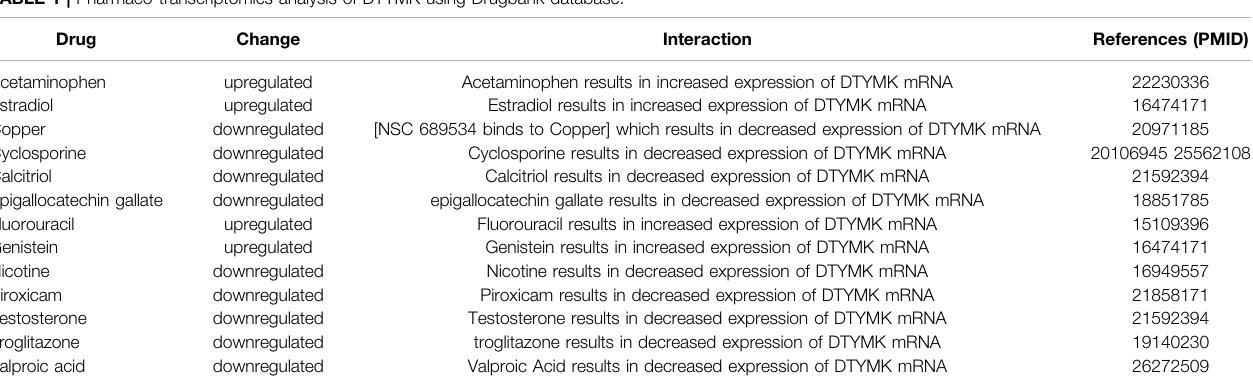
TABLE 1 | Pharmaco-transcriptomics analysis of DTYMK using Drugbank database.